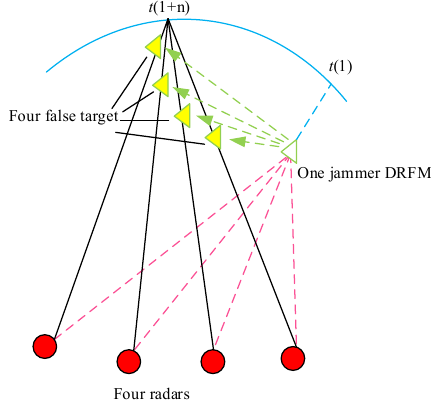
Figure 1. Deception jamming deceives radars based on DRFM.